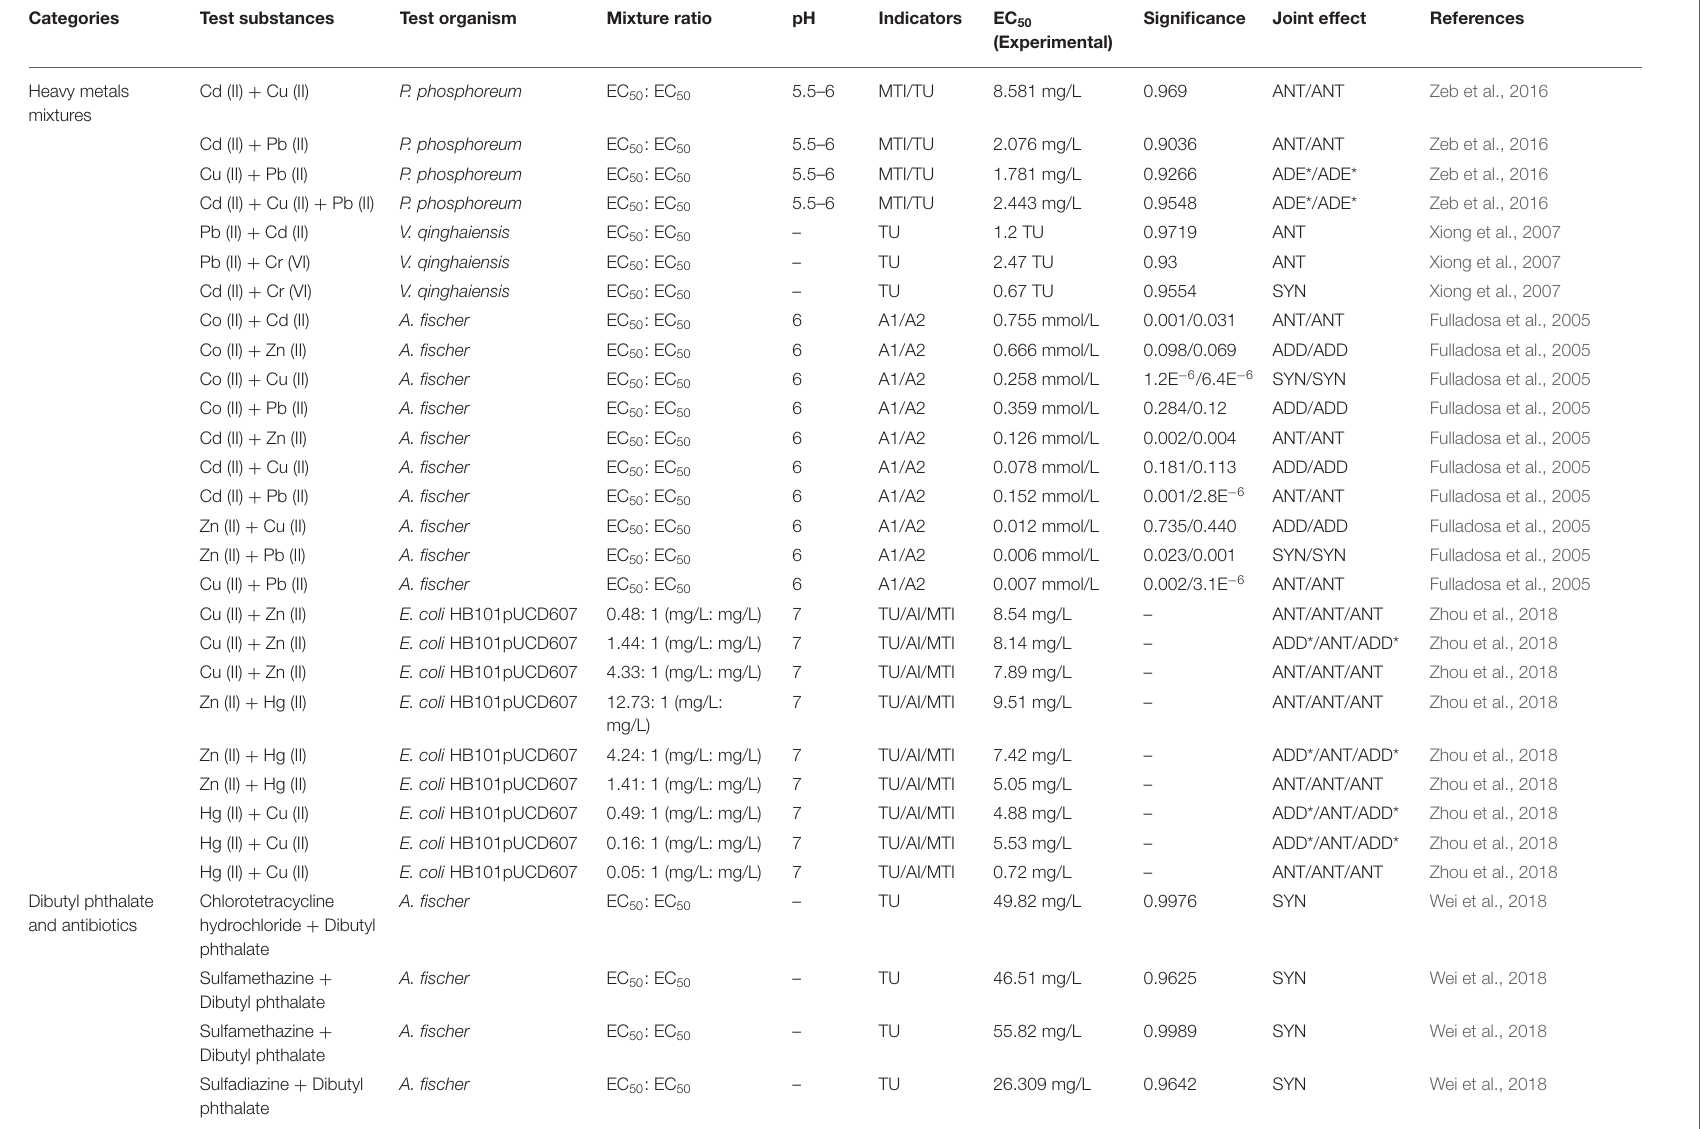
TABLE 3 | Characterization of the acute toxicity of multi-component mixtures assessments associated with TU by luminescent